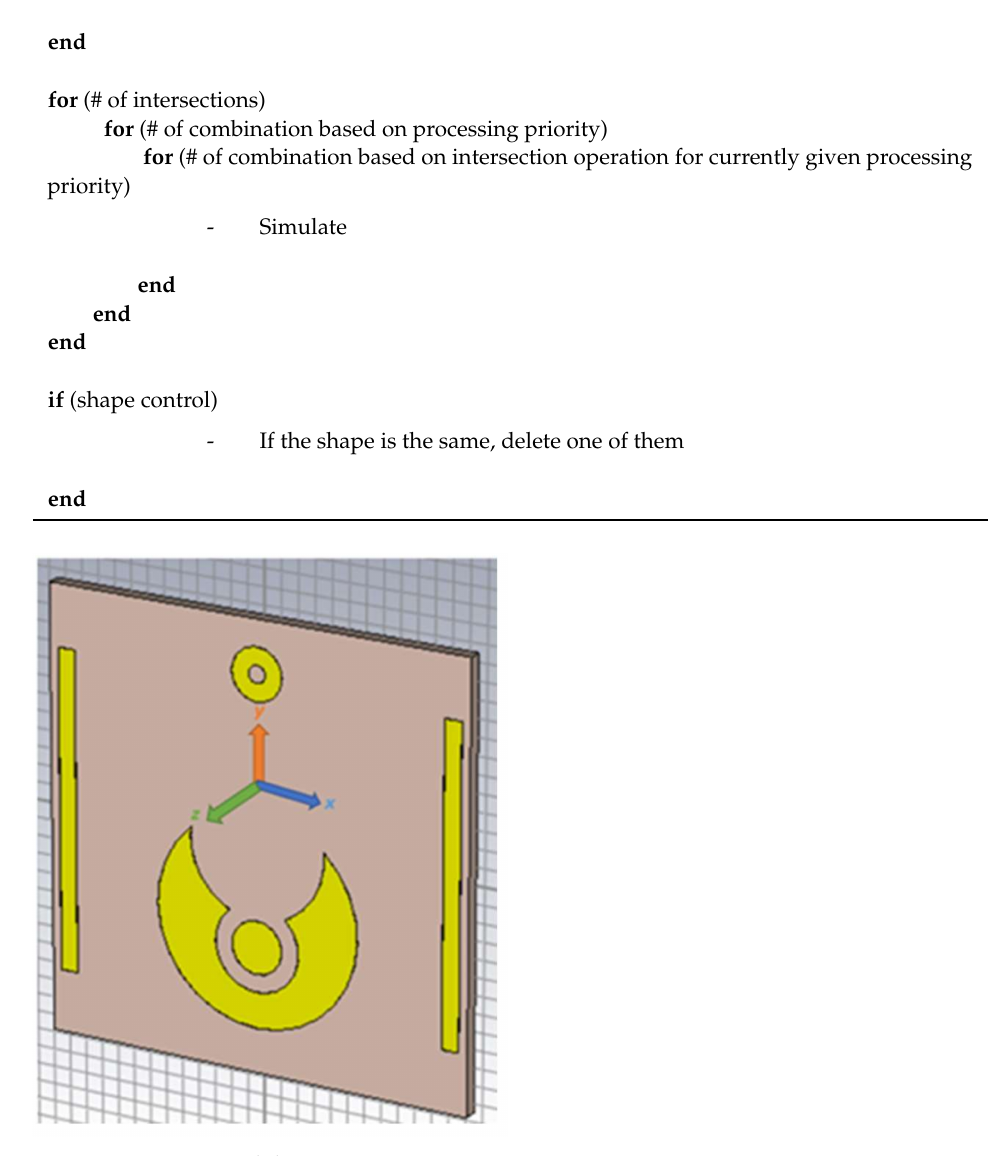
Figure 2. Metamaterial